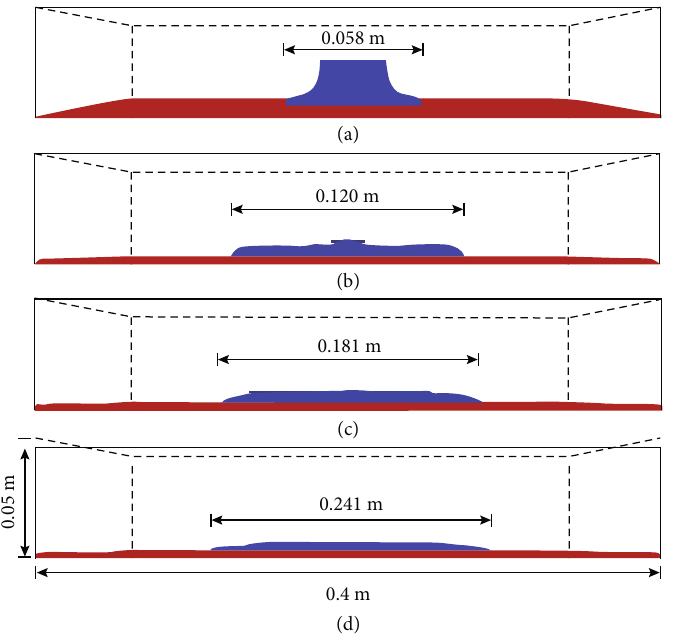
Figure 5: Snap shots of 3D minislump test at time of 0.5s (a), 1.0s (b), 2.0 s (c), and 5.0s